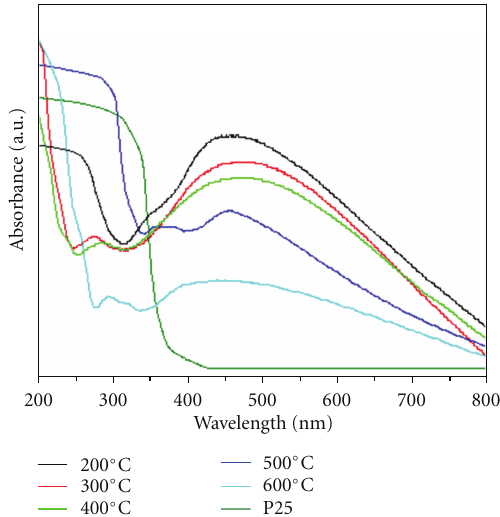
Figure 5: UV-vis di ff use reflectance spectra of IT-T catalysts at various calcination temperatures compared to